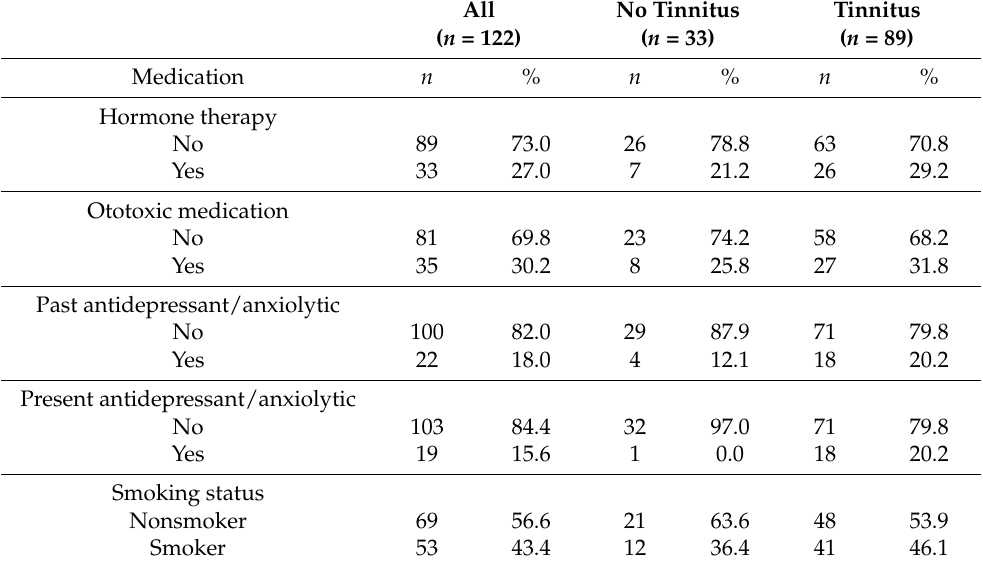
Table 3. Medication related